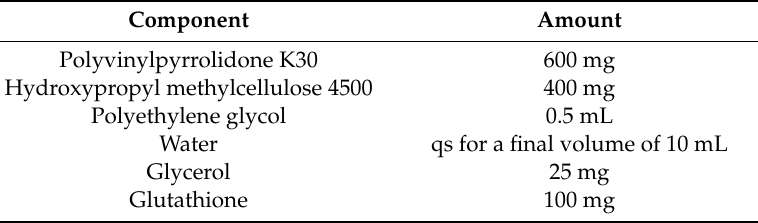
Table 1. GSH ocular semisolid insert